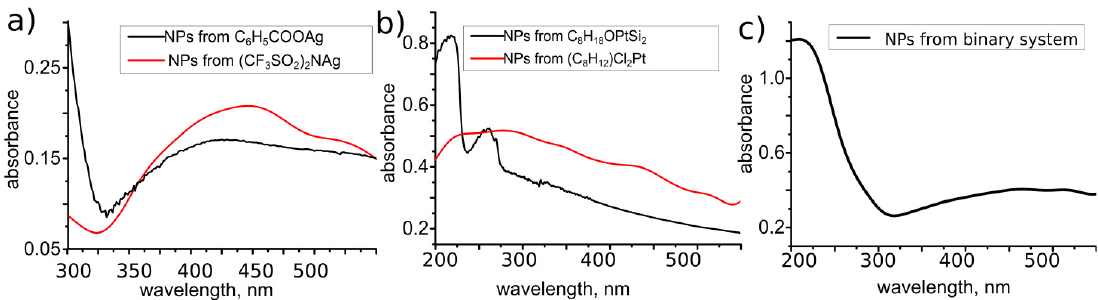
Figure 8. Absorption spectra of nanoparticles (NPs) deposited from ( a ) C 6 H 5 COOAg in methanol and (CF 3 SO 2 ) 2 NAg in isopropanol; ( b ) C 8 H 18 OPtSi 2 in vinyl terminated polydimethylsiloxane and (C 8 H 12 )Cl 2 Pt in dichloromethane; ( c ) mixture of C 6 H 5 COOAg and C 8 H 18 OPtSi 2 in acetonitrile.